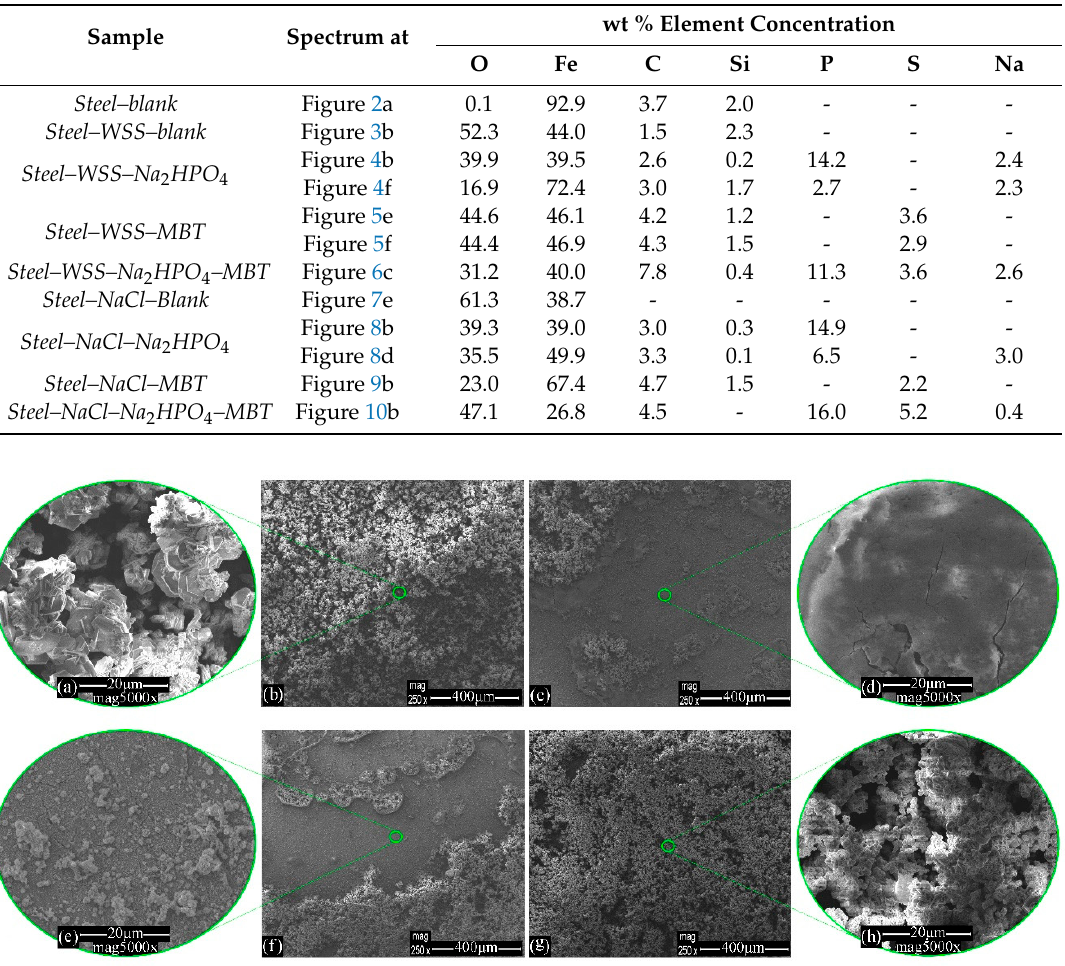
Figure 5. SEM images of mild steel immersed in WSS for 96 h in the presence of MBT.